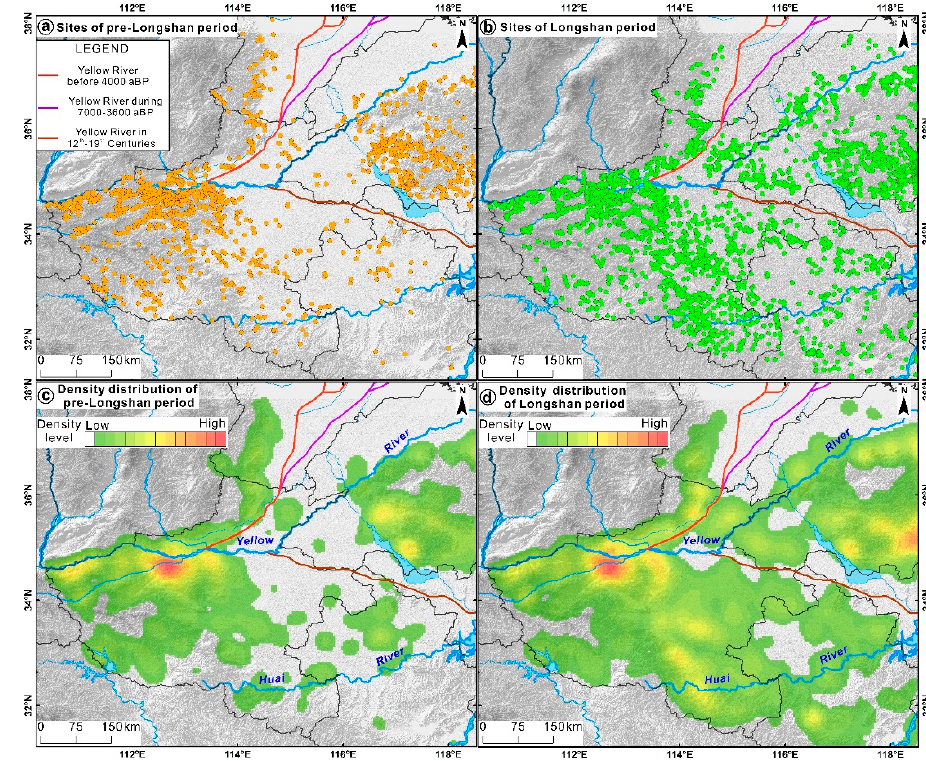
Figure 2. Human settlement distributions of the pre-Longshan period ( a ) and the Longshan period ( b ) and the site density distributions of the pre-Longshan period ( c ) and the Longshan period ( d ) in the study area.